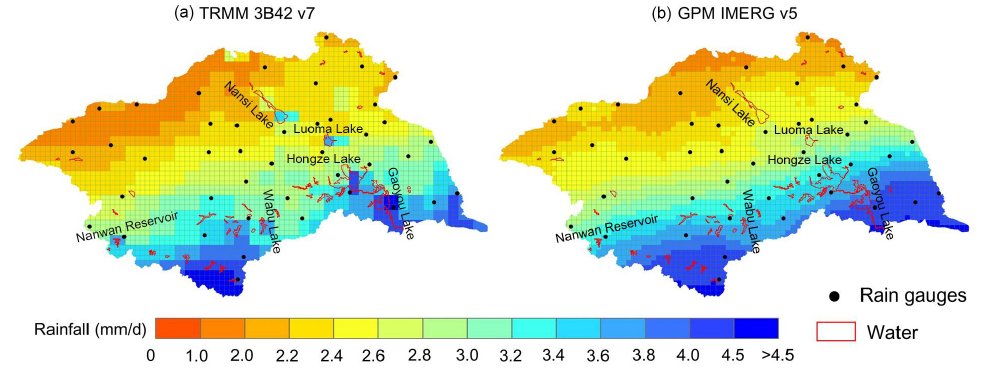
Figure 5. Spatial distribution of TRMM 3B42 v7 ( a ) and GPM IMERG v5 ( b ) mean daily precipitation from 2015 to 2017 in the Huaihe River basin.